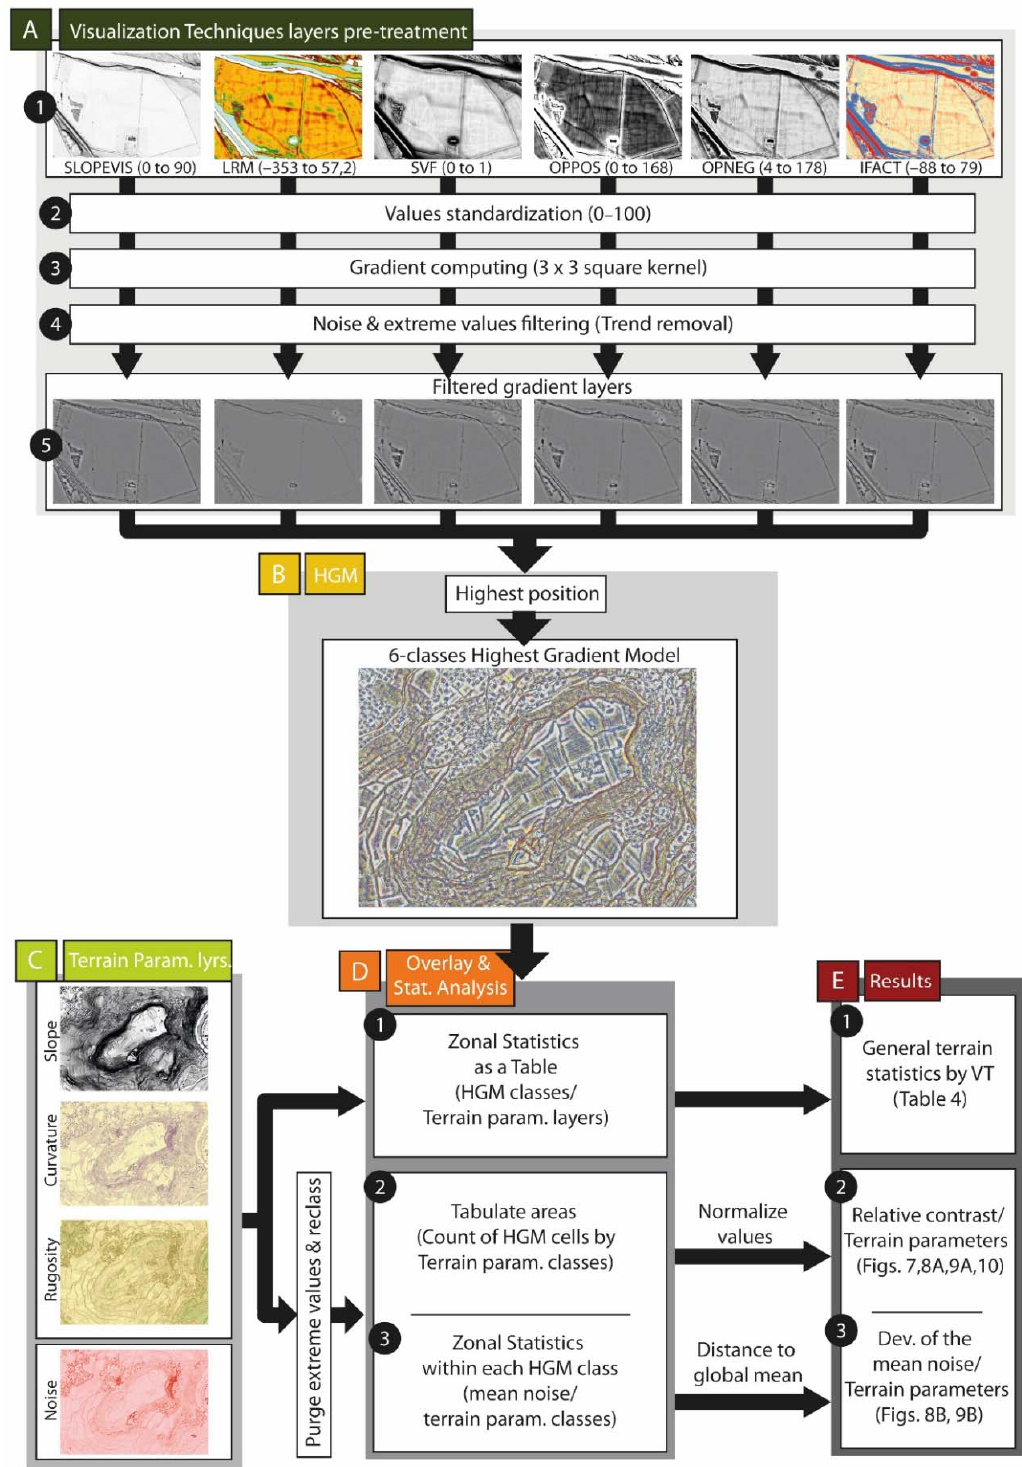
Figure 4. General workflow to compute Highest Gradient Model (HGM) and produce spatial statistics from the six selected VTs.